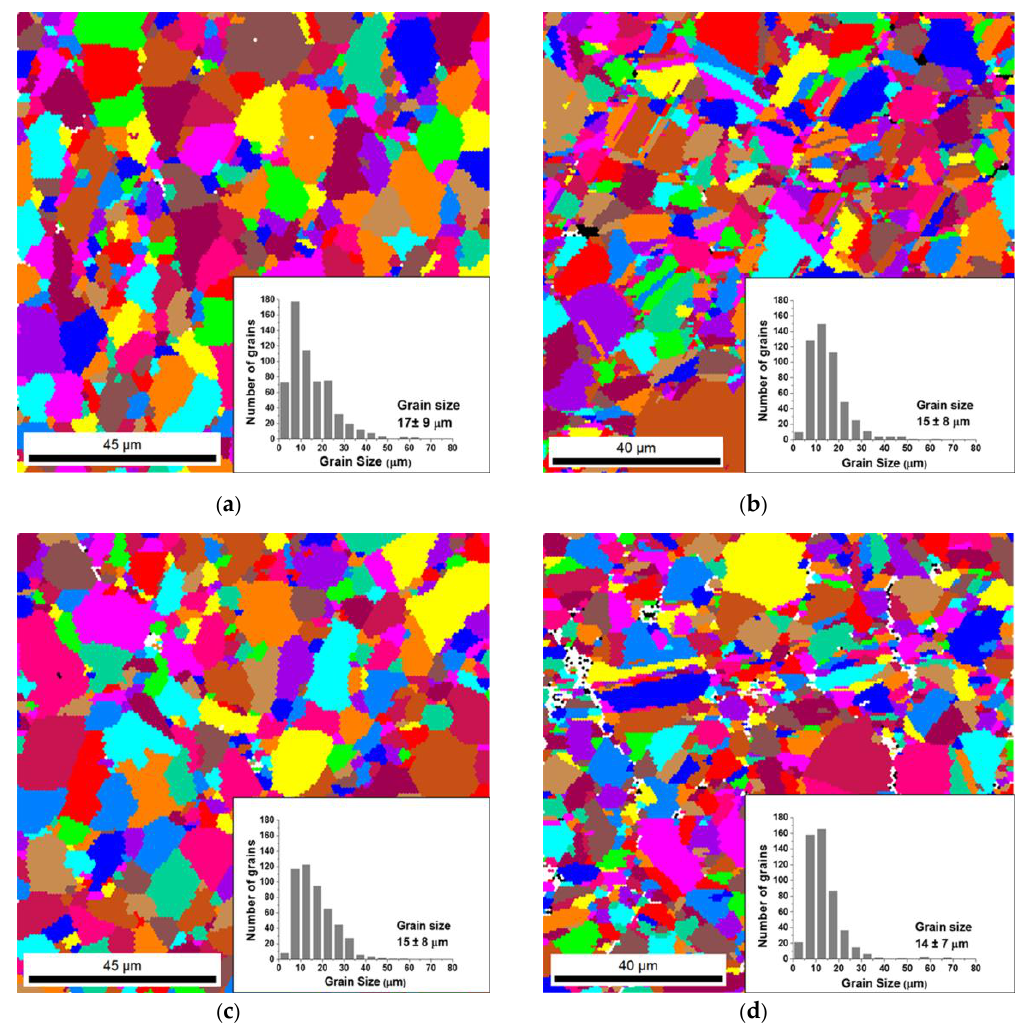
Figure 6. Grain size maps and distributions of the ( a ) aluminum and ( b ) nickel matrices and ( c ) Al/CNTs and ( d ) Ni/CNTs